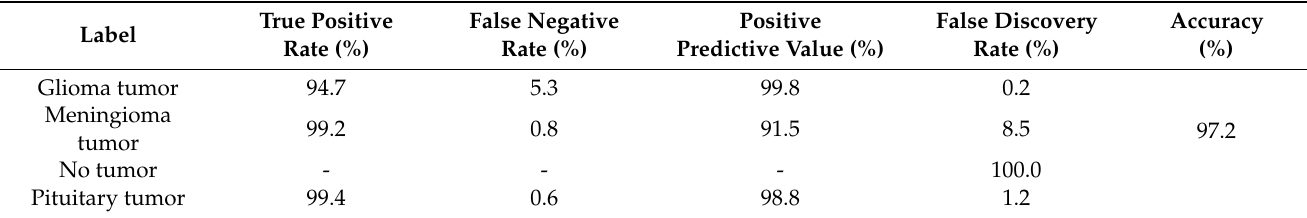
Table 2. Testing performance of the proposed trained model for an unseen dataset.